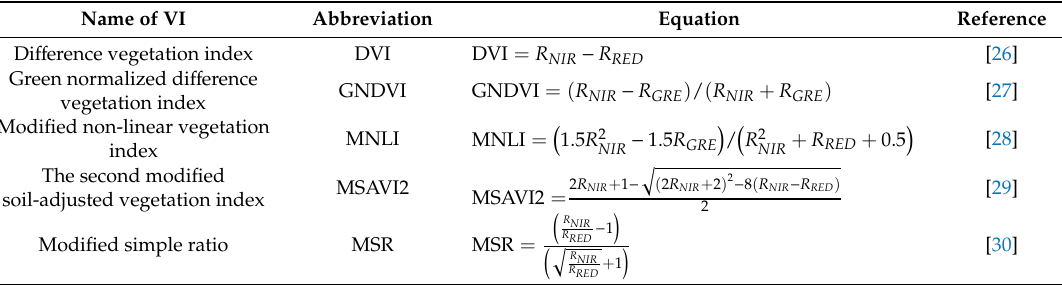
Table 3. VIs derived from the multispectral image used in this study.